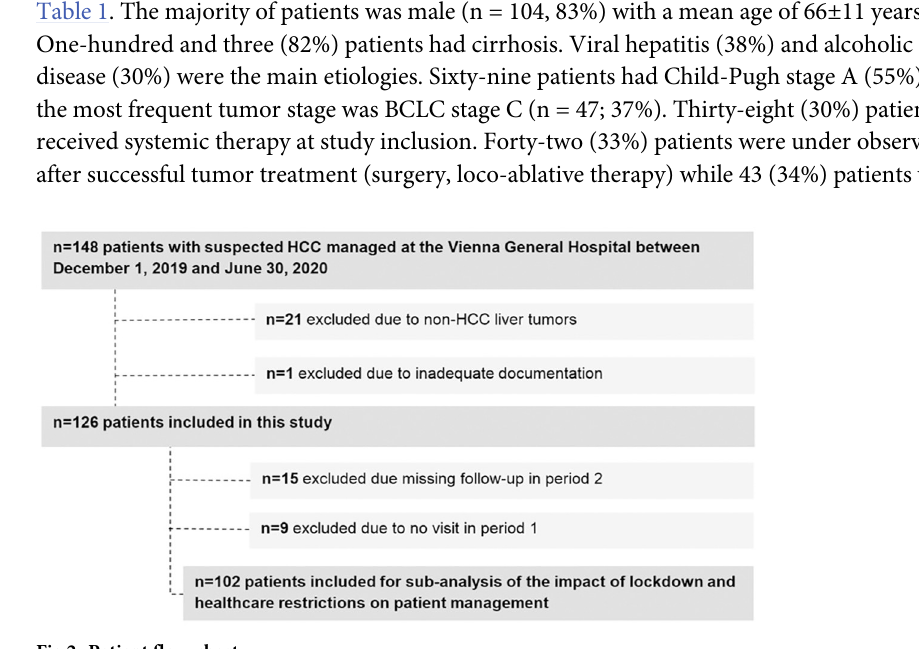
Fig 1. Timeline of COVID-19-associated healthcare restrictions. Measures implemented by A) the Austrian government and B) the Vienna General Hospital, Medical University of Vienna, Department of Internal Medicine, Division of Gastroenterology and Hepatology.